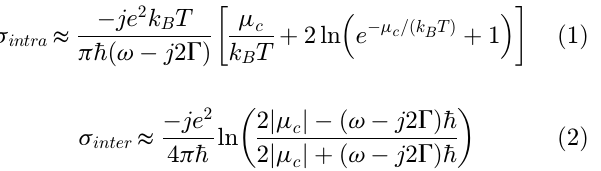
ffiffiffiffiffiffiffiffiffiffiffiffiffiffiffiffiffiffi p e